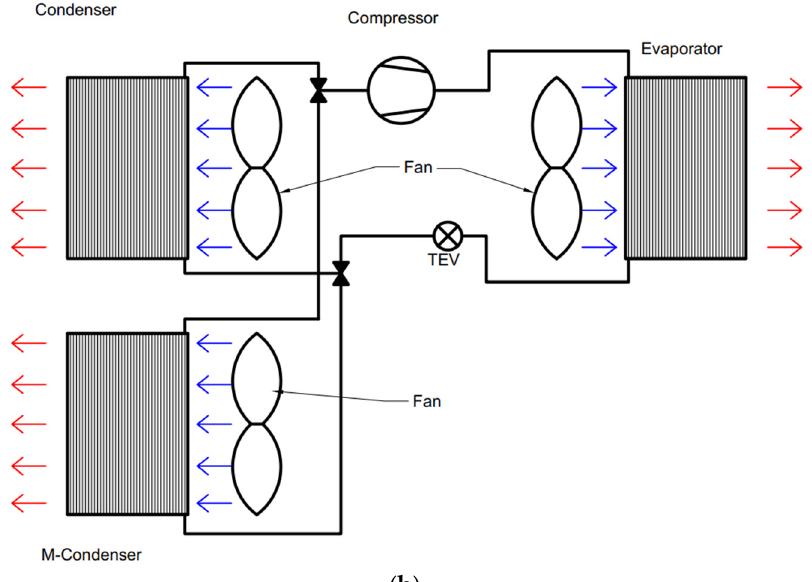
Figure 13. M-condenser: ( a ) EER visualization based on ambient air temperature; ( b ) schematic arrangement [11].